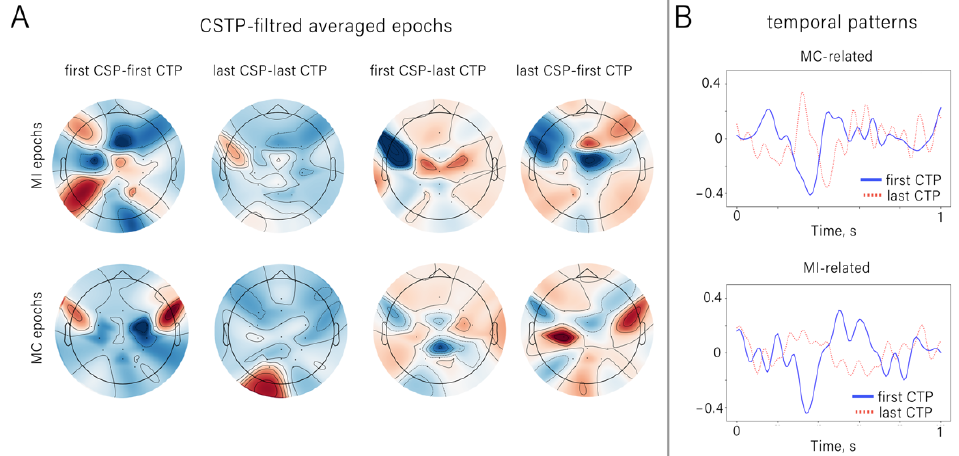
Figure 6. ( A ). Spatial patterns (spatial maps) of the CSTP-processed MI and MC epochs (median over all subjects, epochs and all cross-validation trials). The CSTP filters were obtained for the “MI vs MC” pairs. The captions above the columns of panels denote which spatial and temporal filters were used to obtain a particular component. For example, “first CSP - first CTP'' means that this map resulted from applying the first four temporal filters from Wtemporal, which were obtained from the data processed by the first four spatial filters from Wspatial—which in turn are related to the MI condition, and vice versa. “Last CSP - last CTP” corresponds to the last four temporal filters from Wtemporal obtained from the data processed with the four MC-related spatial filters. ( B ). CSTP patterns of the first and last CTP filters (first and last four columns of Wtemporal (which correspond to the largest and smallest eigenvalues)) obtained from the data spatially filtered with the MI-related CSP filters (first columns of Wspatial) and MC-related CSP filters (last columns of